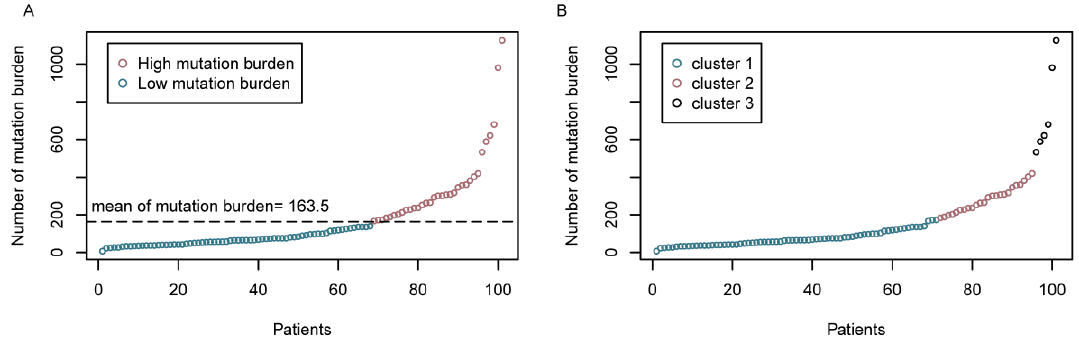
Figure 1. The distribution of TMBs. ( A ) The TMB stratified patients into high mutation burden and low mutation burden types. The threshold is the mean of TMBs of 101 patients, which is equal to 163.5. ( B ) Three clusters divided by optimal univariate k-means clustering and the cluster 1 was strongly similar to the low mutation burden